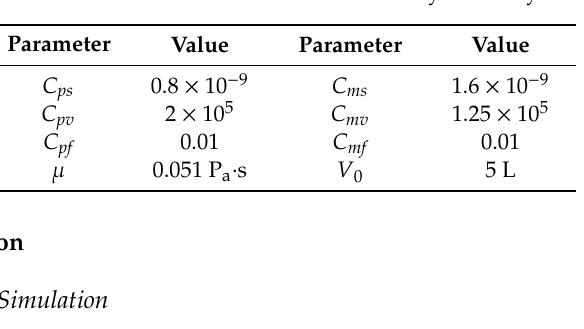
Table 2. Parameters of the simulation of the hydraulic system.